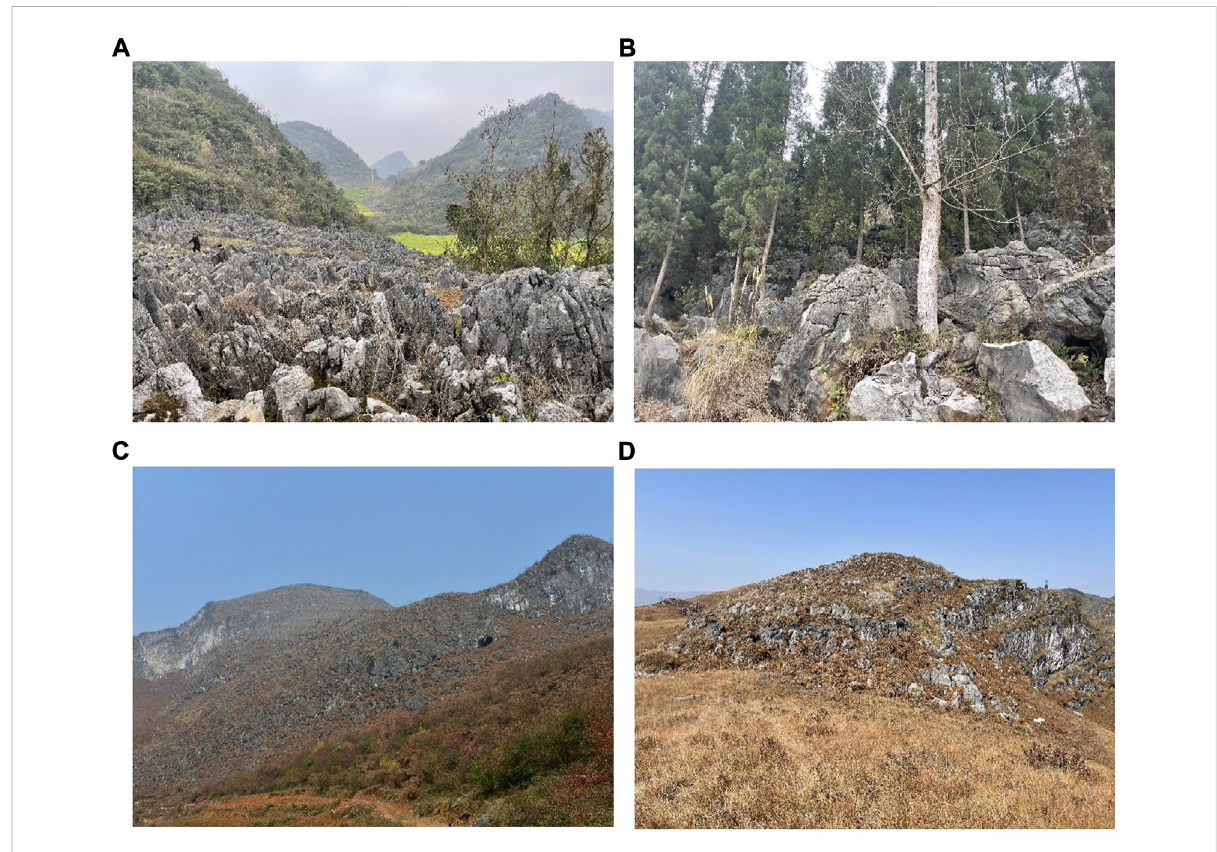
FIGURE 2 Photos of Karst Rocky Deserti fi cation Landscape in Puding County. (A) Farmland rocky deserti fi cation landscape. (B) Rocky deserti fi cation landscape under the forest (C) Rocky deserti fi cation landscape on the hillside (D) Rocky deserti fi cation landscape on top of a